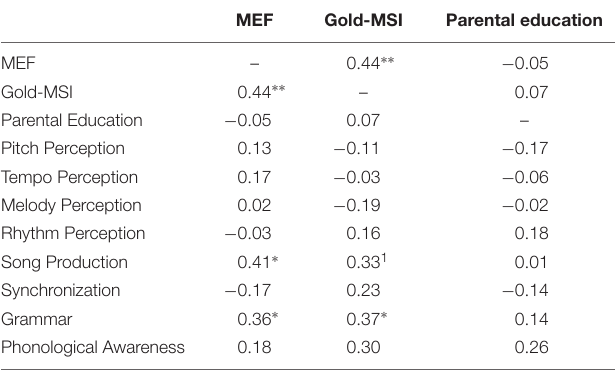
TABLE 7 | Correlations between MEF, Gold-MSI-Musical Sophistication, parental education, and musical